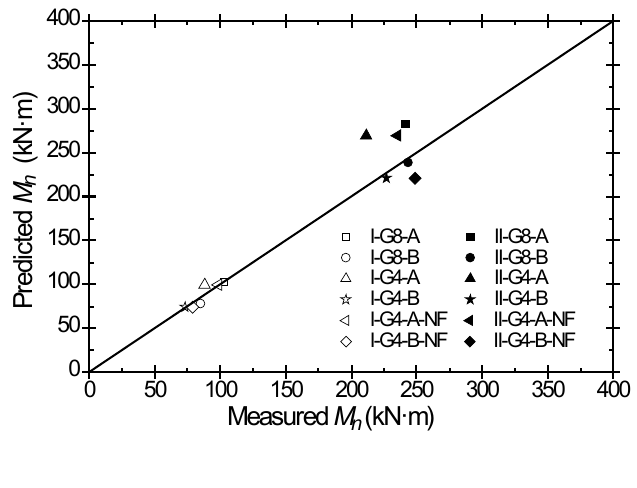
Figure 12. Comparison with measured and predicted ultimate moment